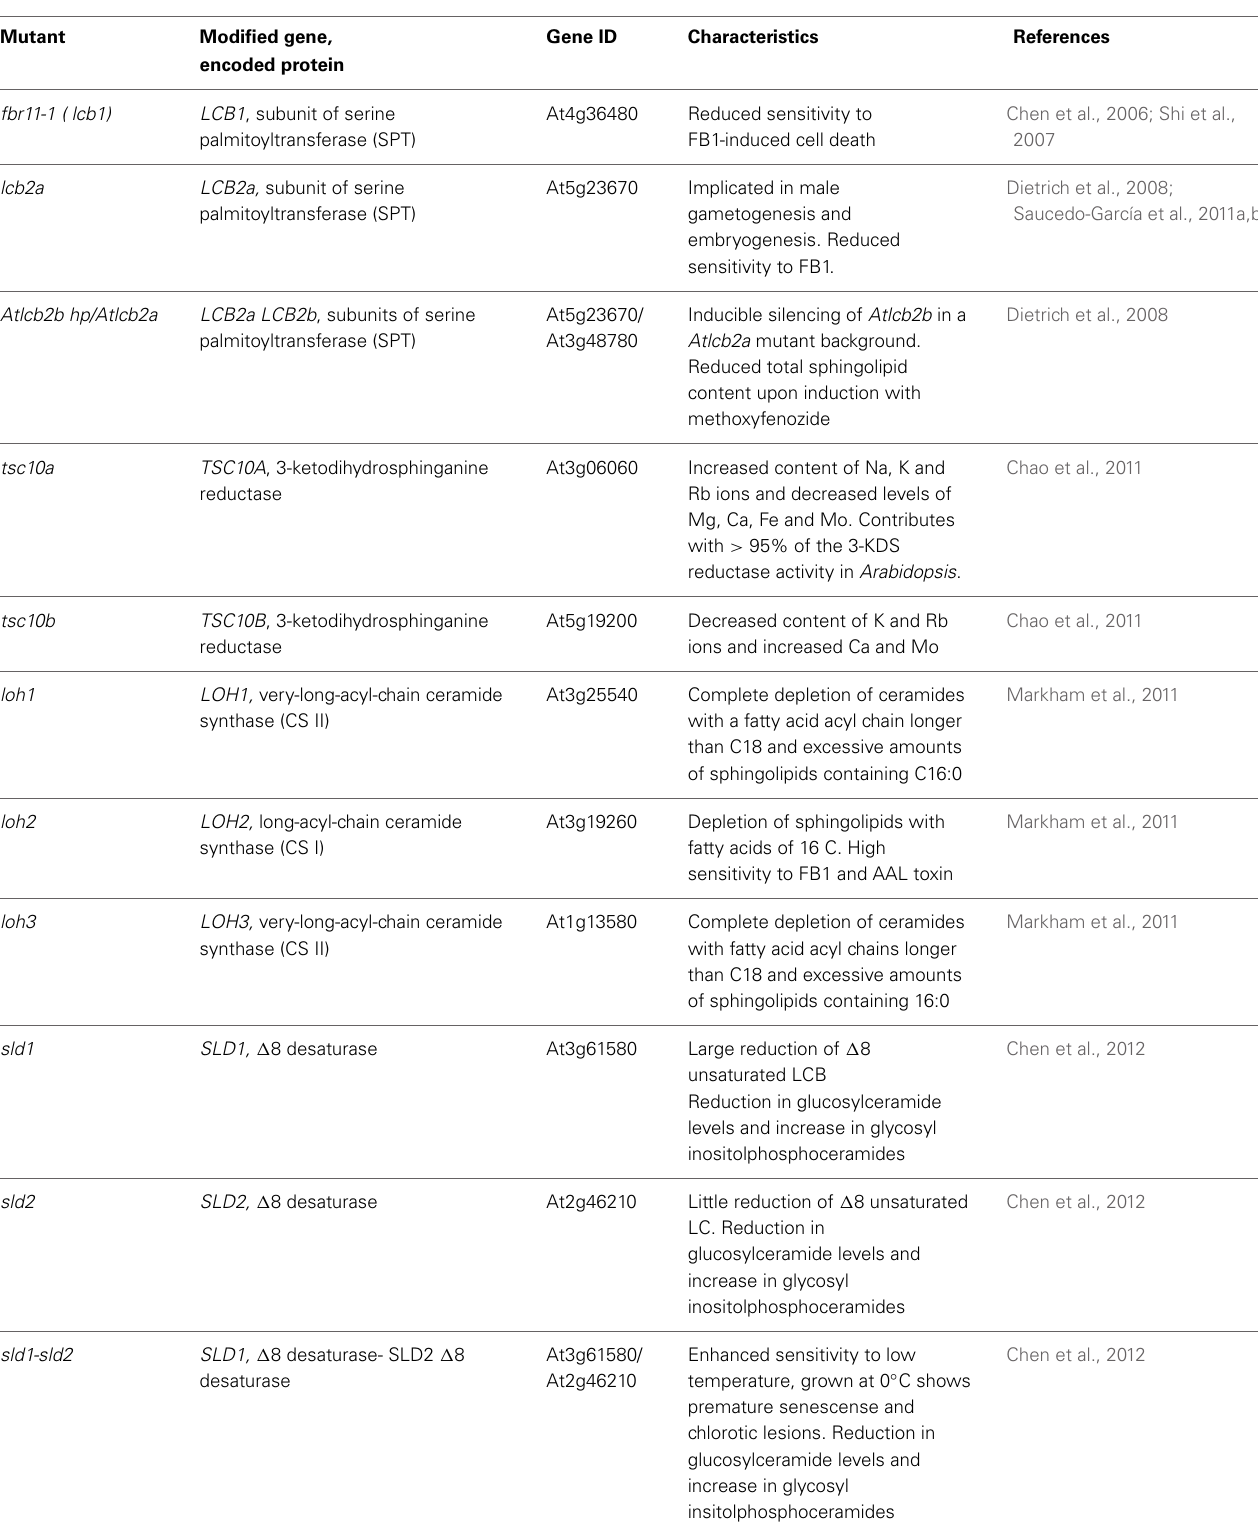
Table 1 | Arabidopsis mutants impaired in sphingolipid metabolism.